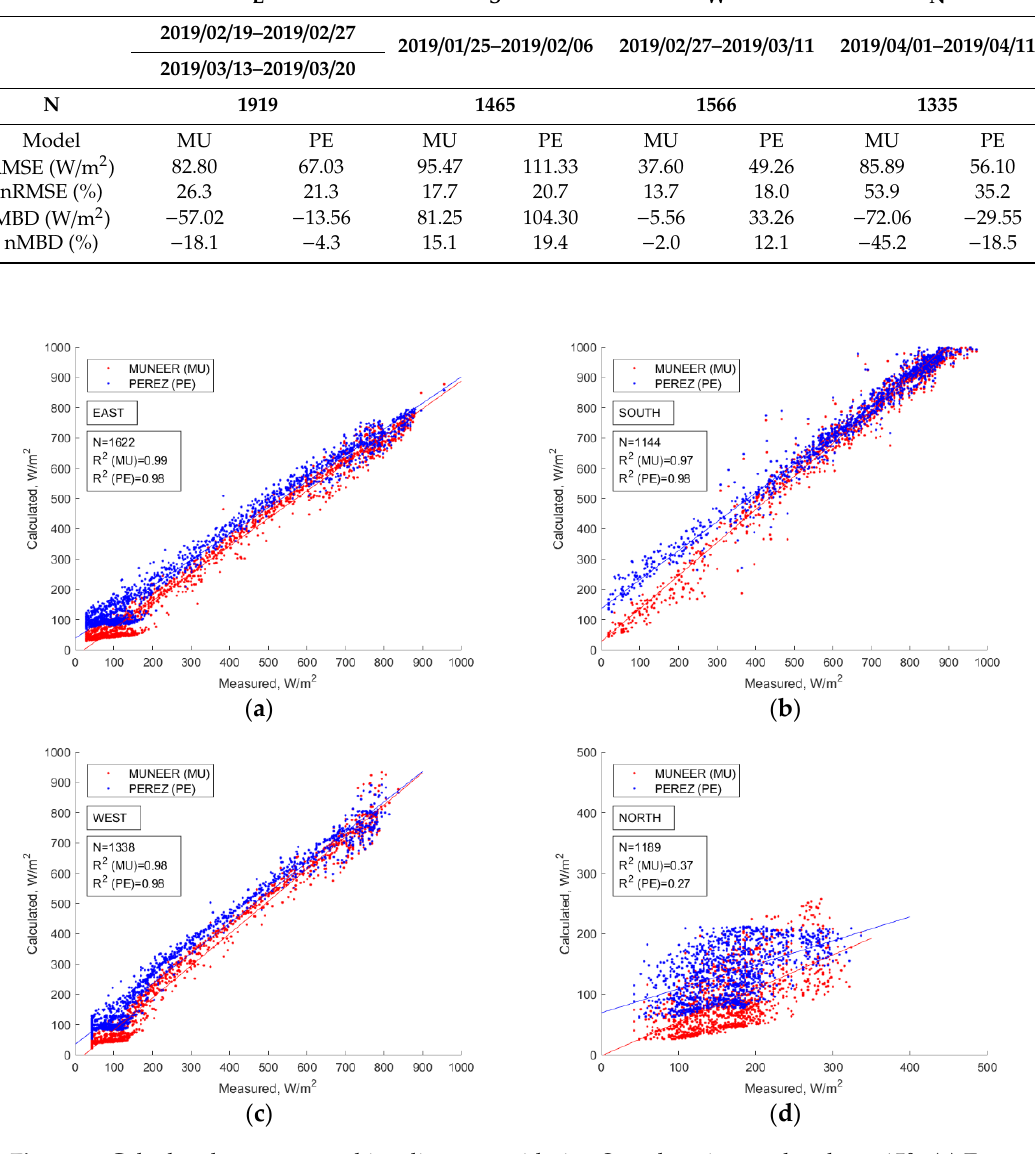
Figure 5. Calculated vs. measured irradiance considering Sun elevation angles above 15°. ( a ) East; ( b ) South; ( c ) West; ( d ) North. Table 4. Results after filtering data by Sun elevation angles.